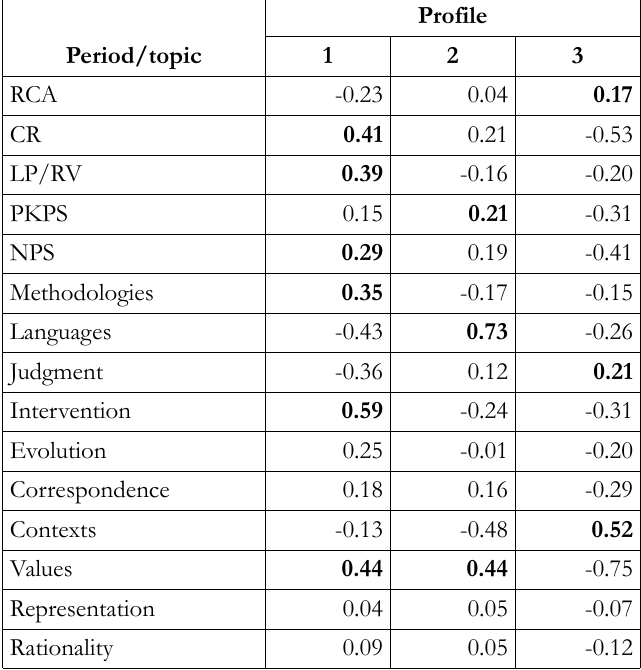
Table 8. Scores for teachers’ NOS